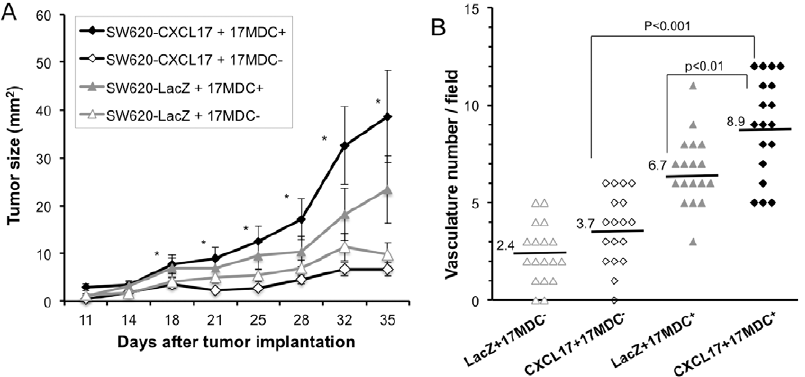
Figure 7. CXCL17-responding myeloid cells promote tumor formation and angiogenesis. (A) CXCL17-responding myeloid-derived cells (17MDC + , 1 6 10 5 ) were collected from the lower chamber of the chemotaxis assay (4-hr incubation), and inoculated subcutaneously into SCID (SHO) mice together with SW620-CXCL17 or -LacZ cells (1 6 10 6 ). CXCL17-unresponding myeloid-derived cells (17MDC 2 , 1 6 10 5 ) were used as control cells. Tumor growth was monitored every 3–4 days following tumor implantation. *, P , 0.05 (Kruskal-Wallis test, SW620-CXCL17 + 17MDC + versus SW620- CXCL17 + 17MDC 2 , SW620-LacZ + 17MDC 2 at day 18–35 following tumor implantation). One of two experiments with similar results is shown. (B) CD31-positive vessels of tumors from SW620-CXCL17 cells with CXCL17-responding cells were counted in five random sections. One of two independent experiments with similar results is shown.